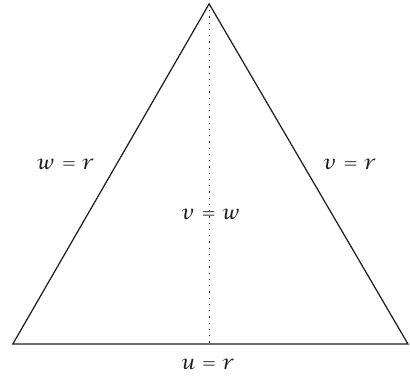
Figure 4.1 . Modal line of